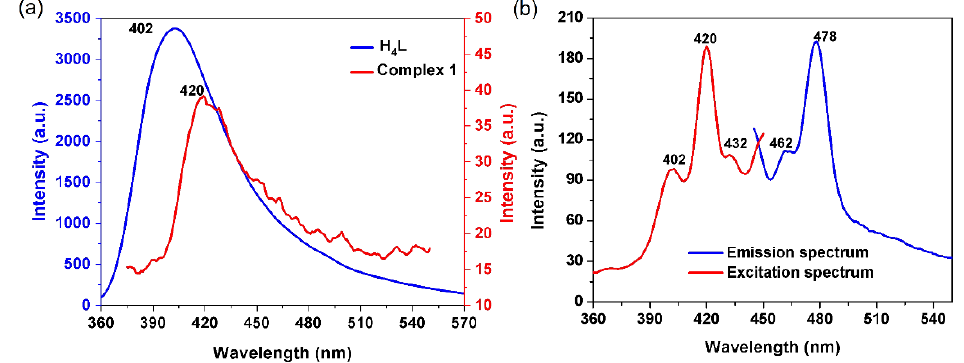
Figure 6. ( a ) Emission spectra of H 4 L and complex 1 in MeCN with λ ex = 350 nm; ( b ) excitation ( λ em = 478 nm) and emission spectra ( λ ex = 420 nm) for complex 1 in MeCN.